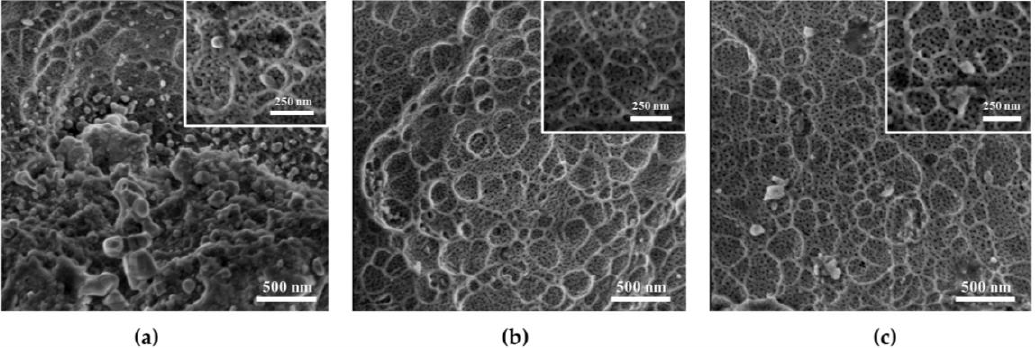
Figure 2. Field emission gun scanning electron microscopy (FEGSEM) inspection of the samples surfaces: ( a ) GHA10, ( b ) GHA50 and ( c ) GHA100. Insets show high magnification details.